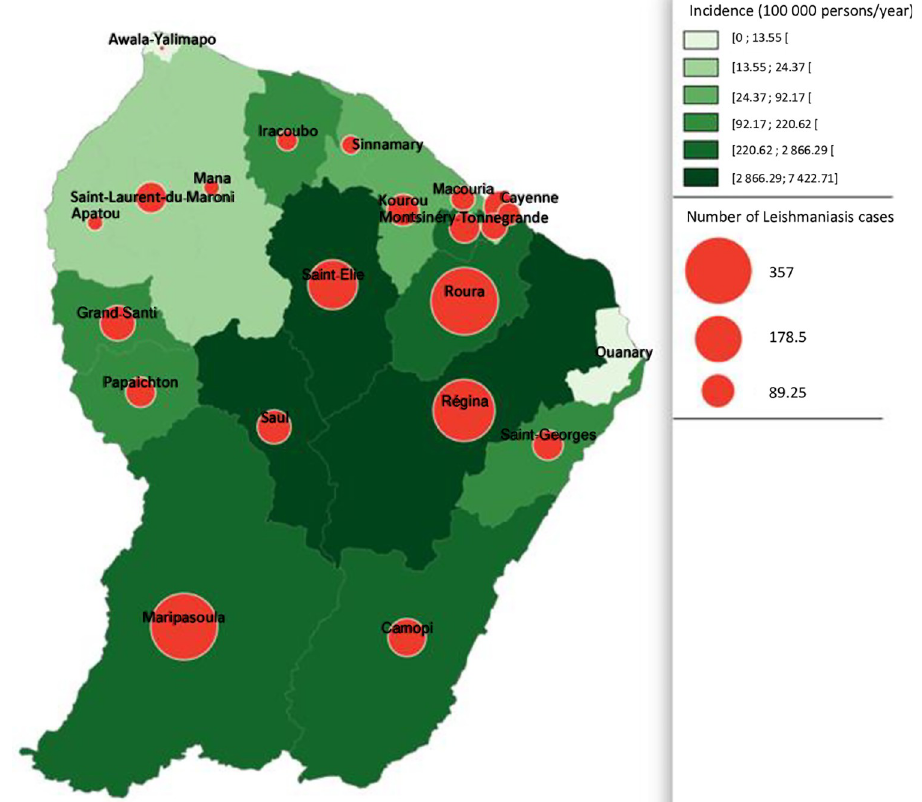
Fig 5. Distribution of the reported leishmaniasis cases in French Guiana by locality from 2003 to 2020). (n = 2193, for others 1933 cases, locality was missing) Maps were designed with the Articque software (https://www.articque.